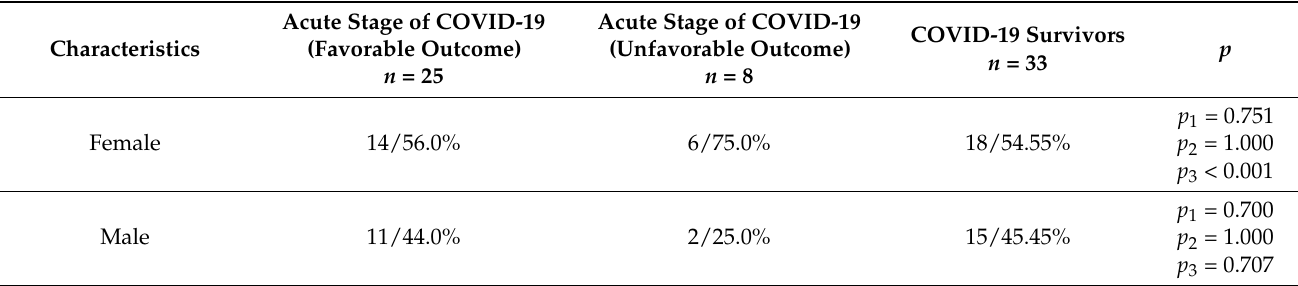
Table 1. Clinical characteristics of groups of